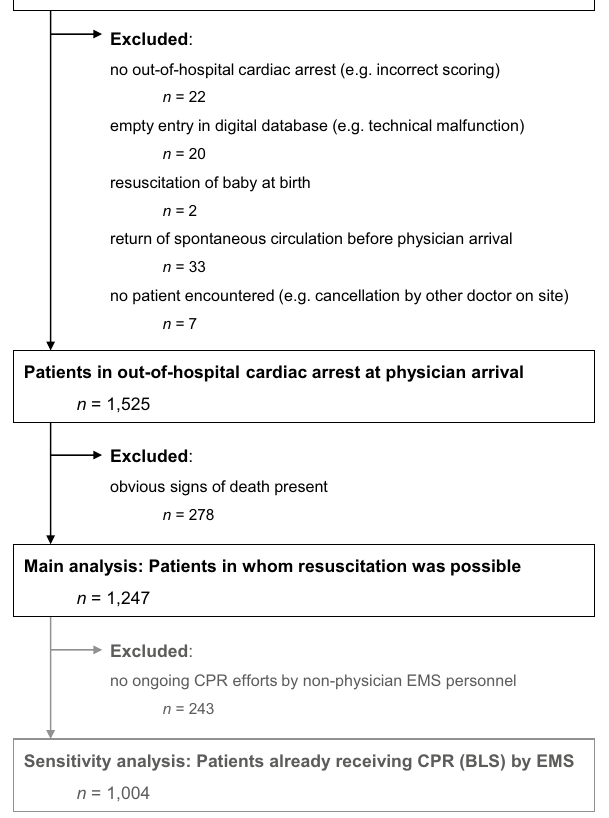
Figure 1. Study flow chart. BLS basic life support, CPR cardio-pulmonary resuscitation, EMS emergency medical services, NACA National Advisory Committee for